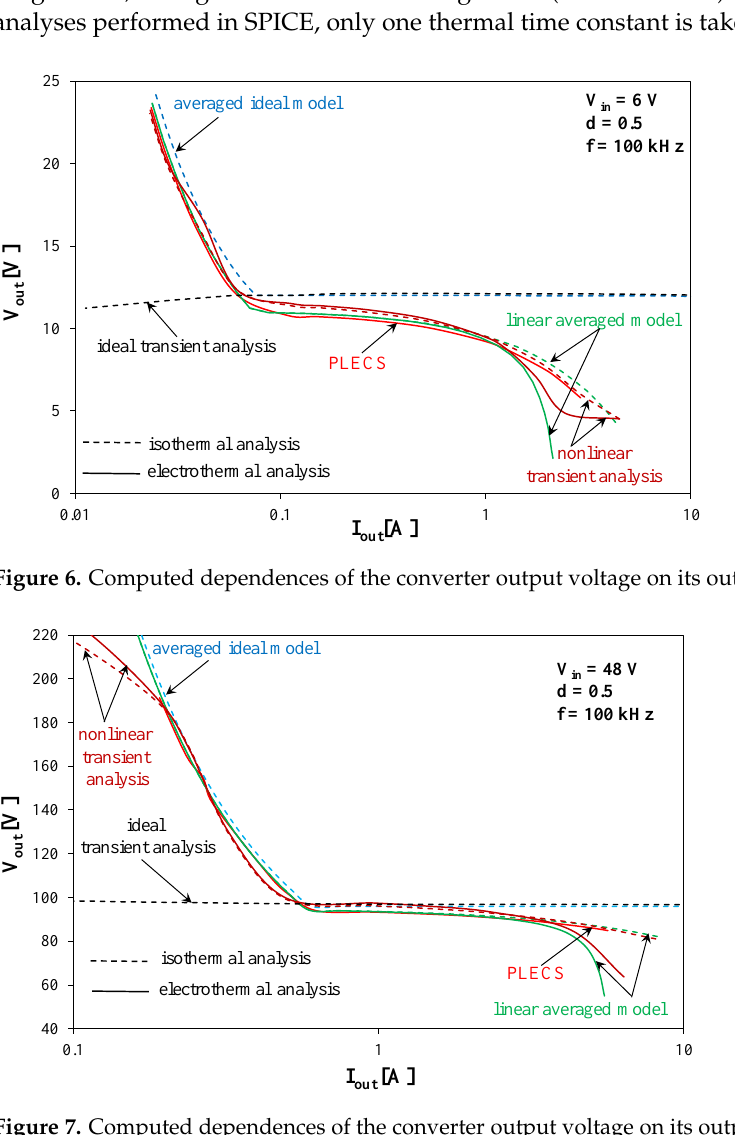
15 of 24 selected DC–DC converters operating at different values of supply voltage and load re- sistance. The investigations were performed for a DC–DC boost converter. The diagram of this converter is presented in Figure 5. V ctr Figure 5. Diagram of the investigated boost converter. In the considered network, the voltage source V in represents the converter input volt- age; whereas, R 0 is load resistance. Voltage source V ctr generates the rectangular pulses train of values equal to zero in a low level and 15 V in a high level, frequency f, and duty cycle d. Values of the components of this converter are as follows: R 1 = 100 Ω, C = 100 μF, and L = 100 μH. The following semiconductor devices are also used: the transistor IRF840 and the diode BY229.